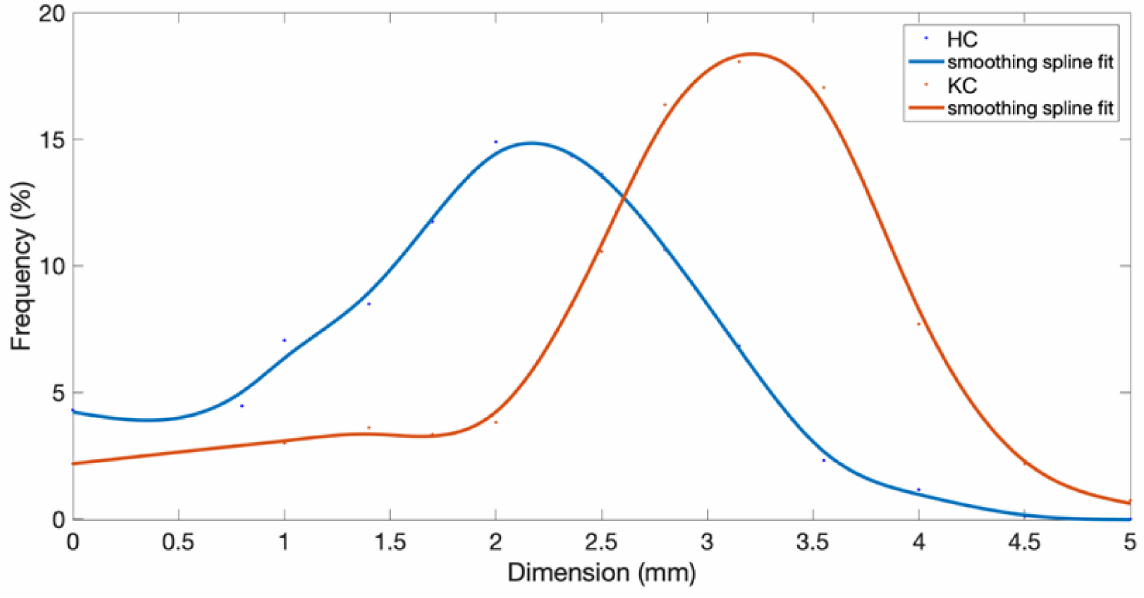
Figure 5. Trends of pit particle size as smoothing spline curves, for hammer crusher (HC) and knife crusher